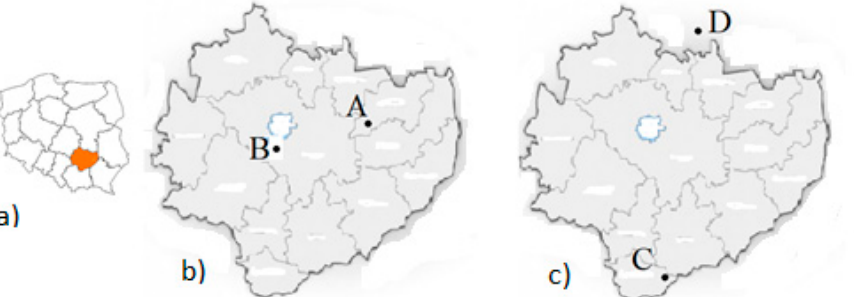
Figure 1. Location of sampling points: ( a ) Poland, Swietokrzyskie Voivodship; ( b ) location of the wastewater treatment plants in the Swietokrzyskie Voivodeship: A. Kunow, B. Sitkowka; ( c ) Jastrzab. Location of soil sampling in the Swietokrzyskie and Mazowieckie Voivodeships: C. Opatowiec, D. Jastrzab.